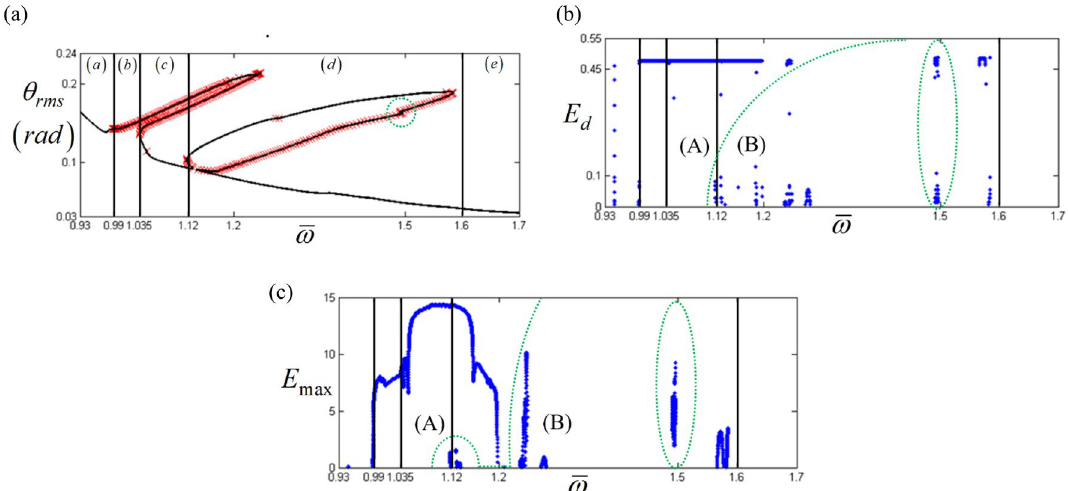
Figure 9. HBM result under unstable conditions compared with the properties of Re ( (cid:31) i ) : ( a ) HBM result at sub-harmonic resonances with various specific areas; ( b ) distribution of positive Re ( (cid:31) i ) along with different solution paths; ( c ) maximum value of positive Re ( (cid:31) i ) along with different solution paths. Key: Black line, HBM result; Red times , HBM result with unstable